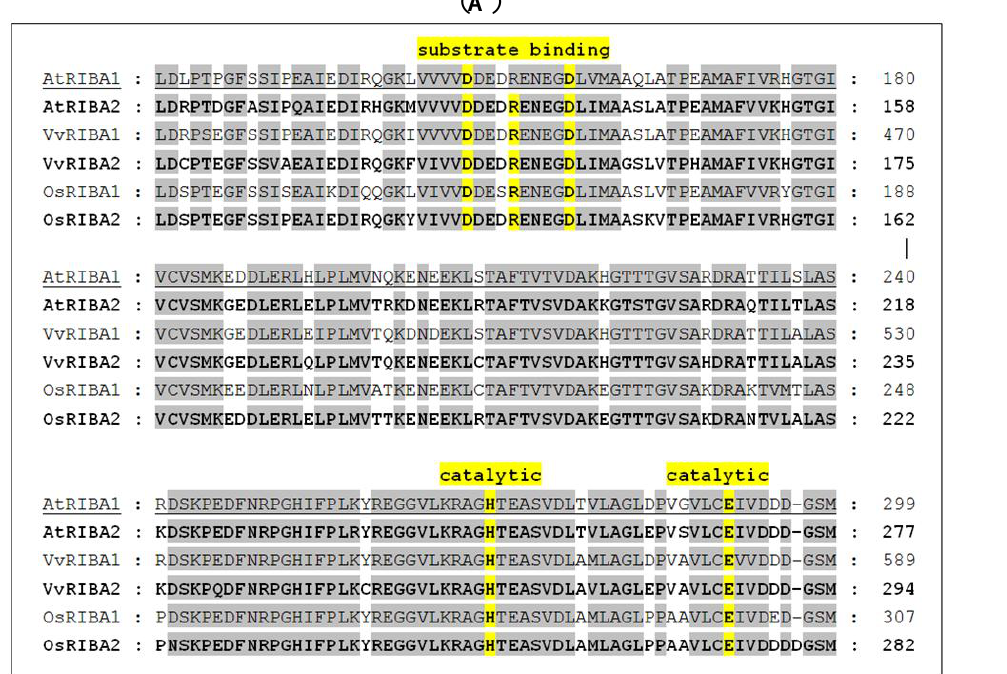
Figure S2. Alignment of RIBA1 and RIBA2 isoforms. Sequence comparison of higher plant RIBA1 and RIBA2 (bold) proteins with bifunctional AtRIBA1 (underlined). Enzymatically important amino acid residues for DHBPS ( A ) and GCHII ( B ) function are highlighted in yellow. Deviations in zinc binding residues as well as a C -terminal deletion uniquely present in AtRIBA2 are marked in red. The loss of essential amino acids is restricted to the GCHII part of AtRIBA2, qualifying all other RIBA2 isoforms as truly bifunctional